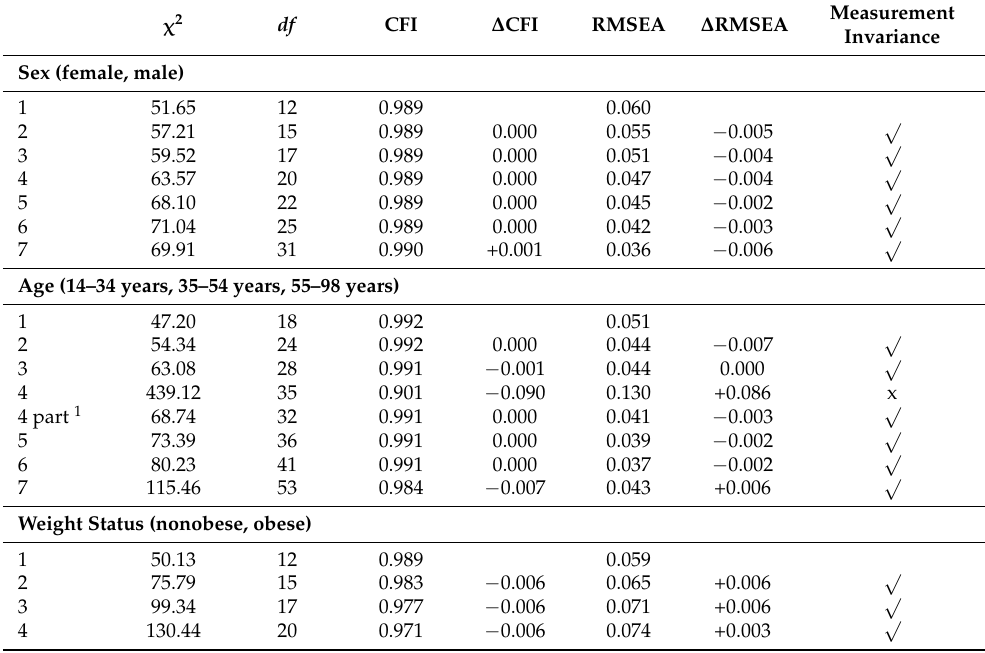
Table 3. Measurement invariance analyses of the Hedonic Overeating–Questionnaire (HEDO–Q) for sex, age, and weight status ( N =